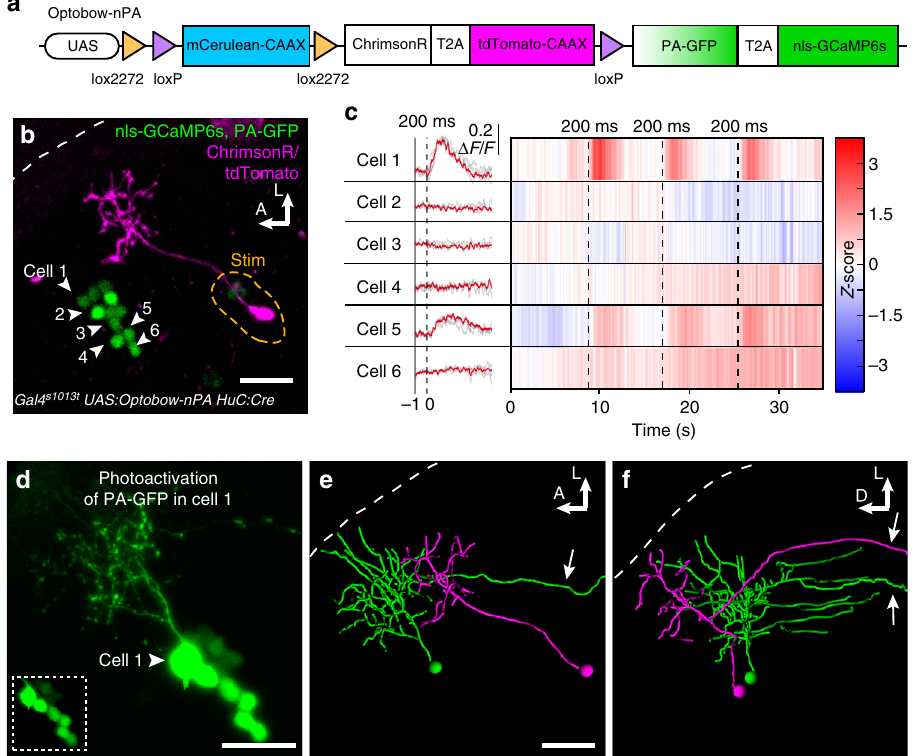
Fig. 3 PA-GFP reveals morphologies of functionally connected cells. a In Optobow-nPA, all ‘ nls-GCaMP6s ’ cells co-express PA-GFP. b Optobow-nPA expression in the optic tectum. A single ChrimsonR-expressing cell ( magenta ) was photostimulated ( orange dashed line ) and GCaMP fl uorescence was monitored in six neighbouring cells by line scans across the nuclei. Note that PA-GFP is not detectable before its activation. Scale bar, 20 µ m. c Calcium measurements acquired at 250 fps for the GCaMP cells annotated in b . Raw ( grey ) and averaged Δ F / F responses ( red ) are shown on the left , heat maps for Z -scores are on the right . Photostimulation epochs of 200 ms are indicated by dashed lines. Cell#1 and #5 showed reliable calcium responses upon photostimulation. d Close-up of cell#1 after photoactivation of PA-GFP. A less saturated, single slice of the cell body region shown in the lower left demonstrates exclusive photoactivation of cell#1. Scale bar, 20 µ m. e , f Three-dimensional fi lament reconstruction of the presynaptic cell ( magenta ) and cell#1 ( green ) in dorsal view ( e ) and transverse view ( f ). The presynaptic cell is a bistrati fi ed projection neuron, and cell#1 is a non-strati fi ed projection neuron. Descending projection axons are marked ( arrows ). Scale bar , 20 µ